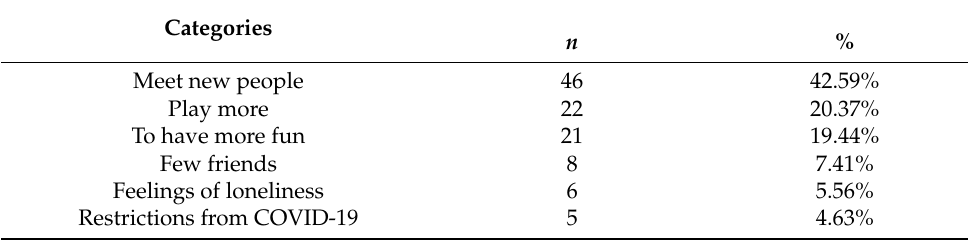
Table A8. Reasons for wanting more